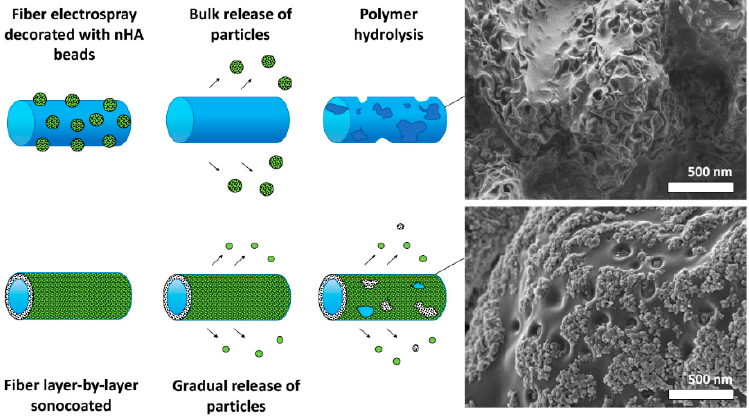
Figure 14. Scheme of particles release mechanism and SEM images of Electrosprayed ( top ) and Sonocoated ( down ) PDLLA/PLGA fibers after 10 weeks of degradation.